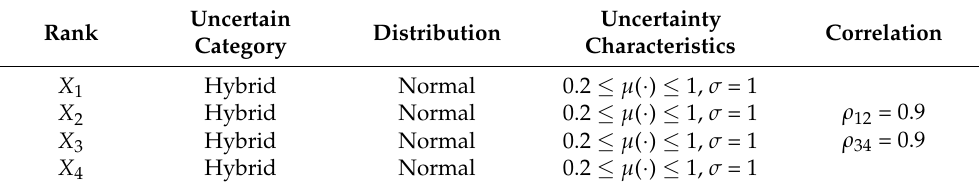
Table 1. Distribution types and parameters of variables.